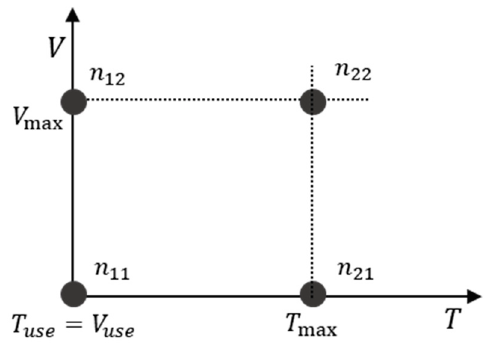
Figure 2. The test units and stress levels of four test points in the first phase.